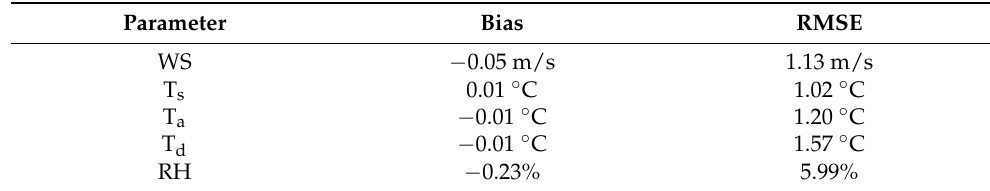
Table 2. The bias and root-mean-square error (RMSE) of the multi-parameter BPNN model-retrieved sea surface wind speed (WS), sea surface temperature (T s ), near-surface air temperature (T a ) and dewpoint temperature (T d ), and relative humidity (RH).